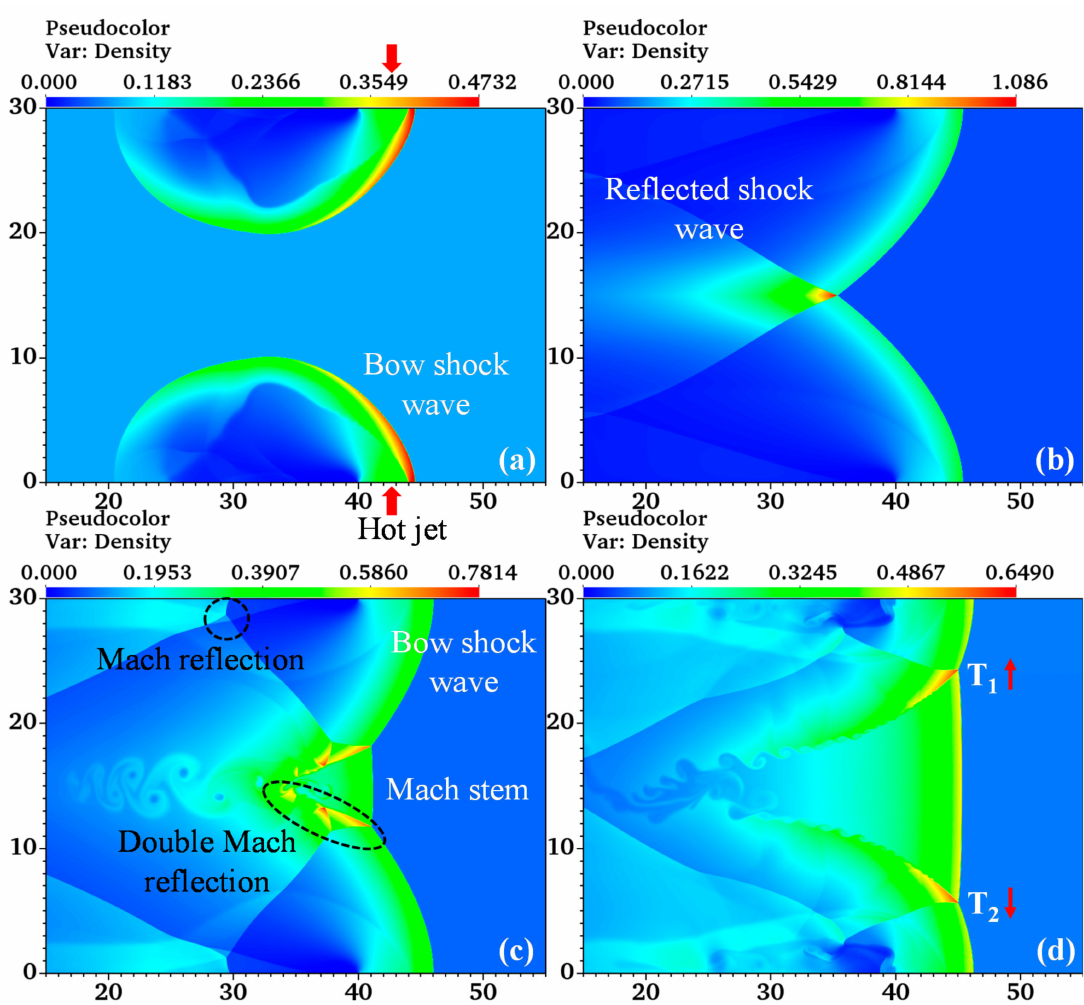
Figure 6. Density contours showing detonation initiation in straight channel, with continuous injection of a symmetric jet: ( a ) t = 110 µ s; ( b ) t = 130 µ s; ( c ) t = 160 µ s; ( d ) t = 180 µ